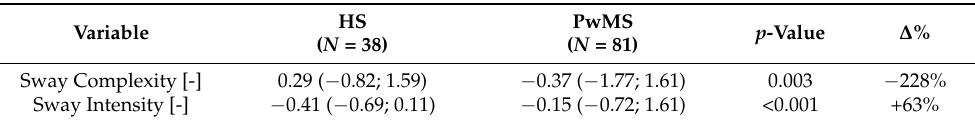
Table 4. ImRomberg components scores for healthy subjects (HS) and people with multiple sclerosis